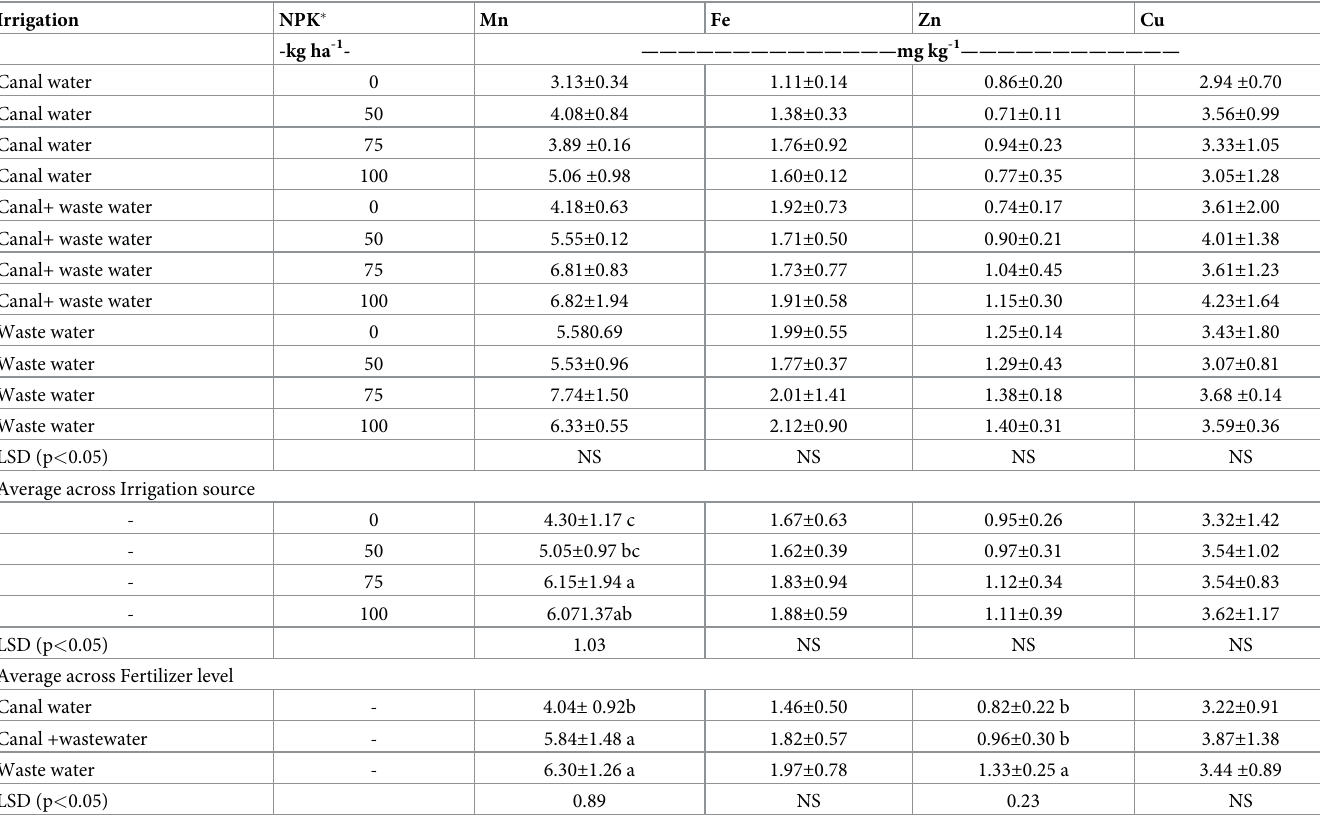
Table 4. Soil heavy metal (Mn, Fe, Zn and Cu) as influenced by NPK level and irrigation source.